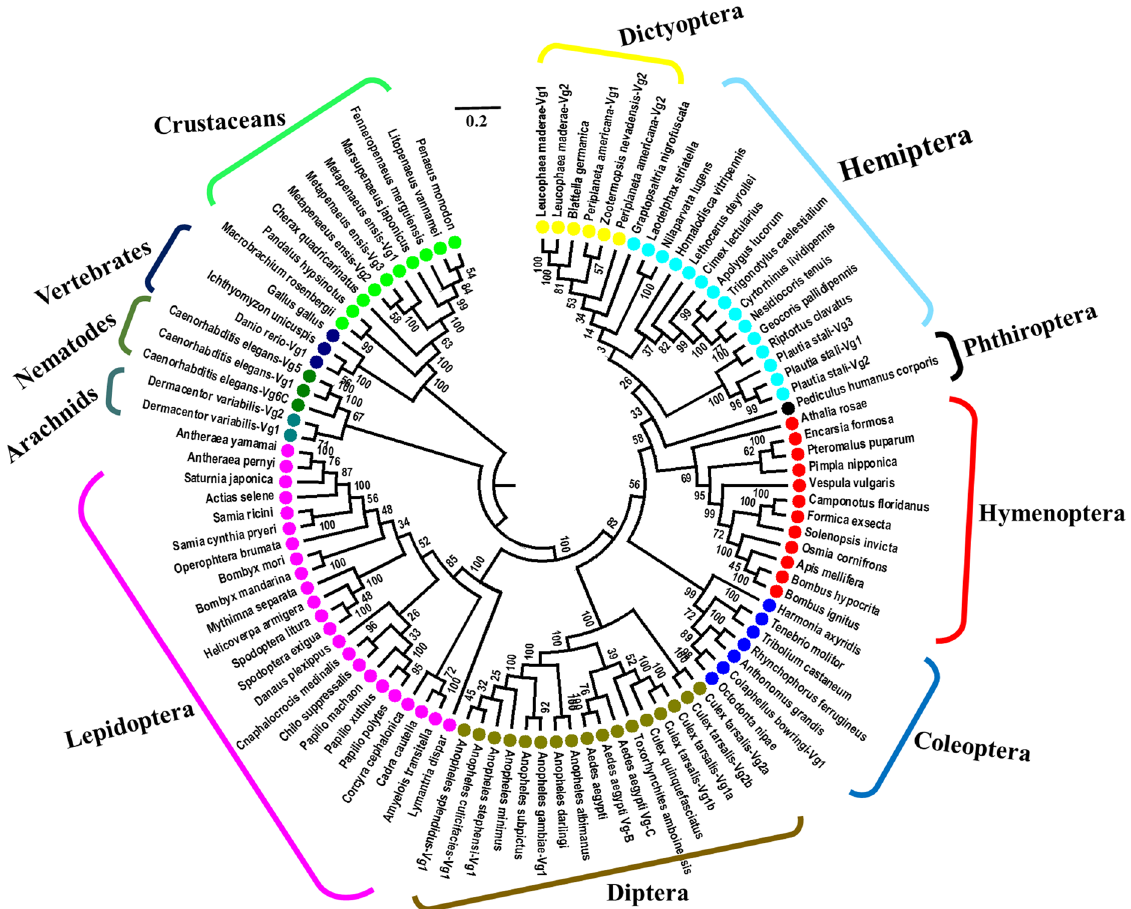
Figure 1. Neighbor-joining phylogenetic tree of 99 insects and non-insect Vg protein sequences. The Clustal W program was used for distance analysis of amino acid sequences and the neighbor-joining tree was constructed by using MEGA 6 software program 74 . Scale 0.2 indicates distance (number of amino acid substitutions per site) 45 Species belonging to different orders have been indicated with different colors.